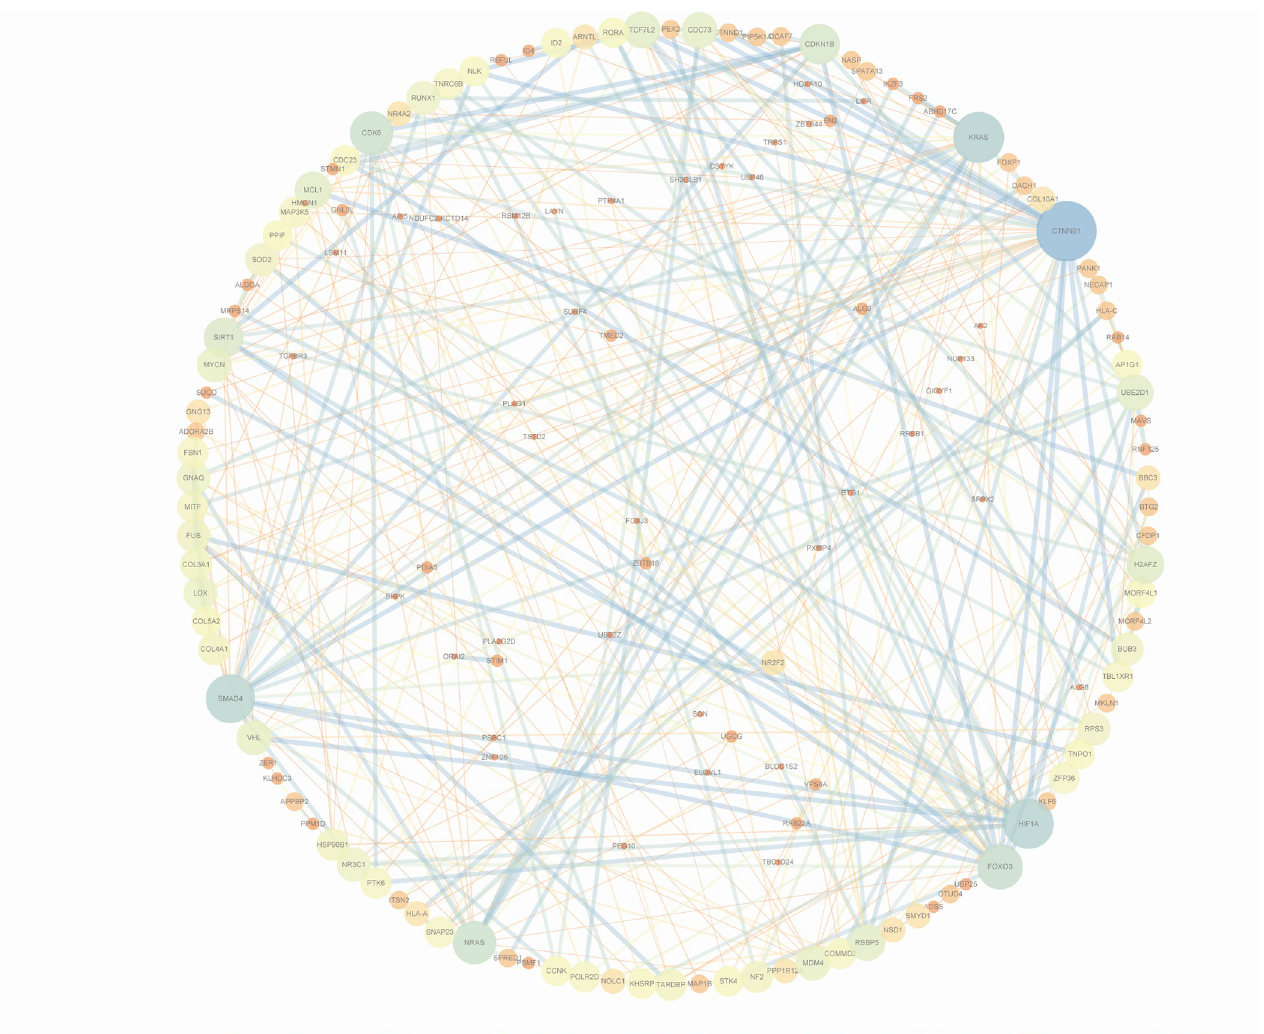
Fig 8. Protein-protein interaction (PPI) network. SMAD4, HIF1A, CTNNB1, CDKN1B, CDK6, FOXO3, KRAS and NRAS are the group of core proteins screened using NetworkAnalyzer.